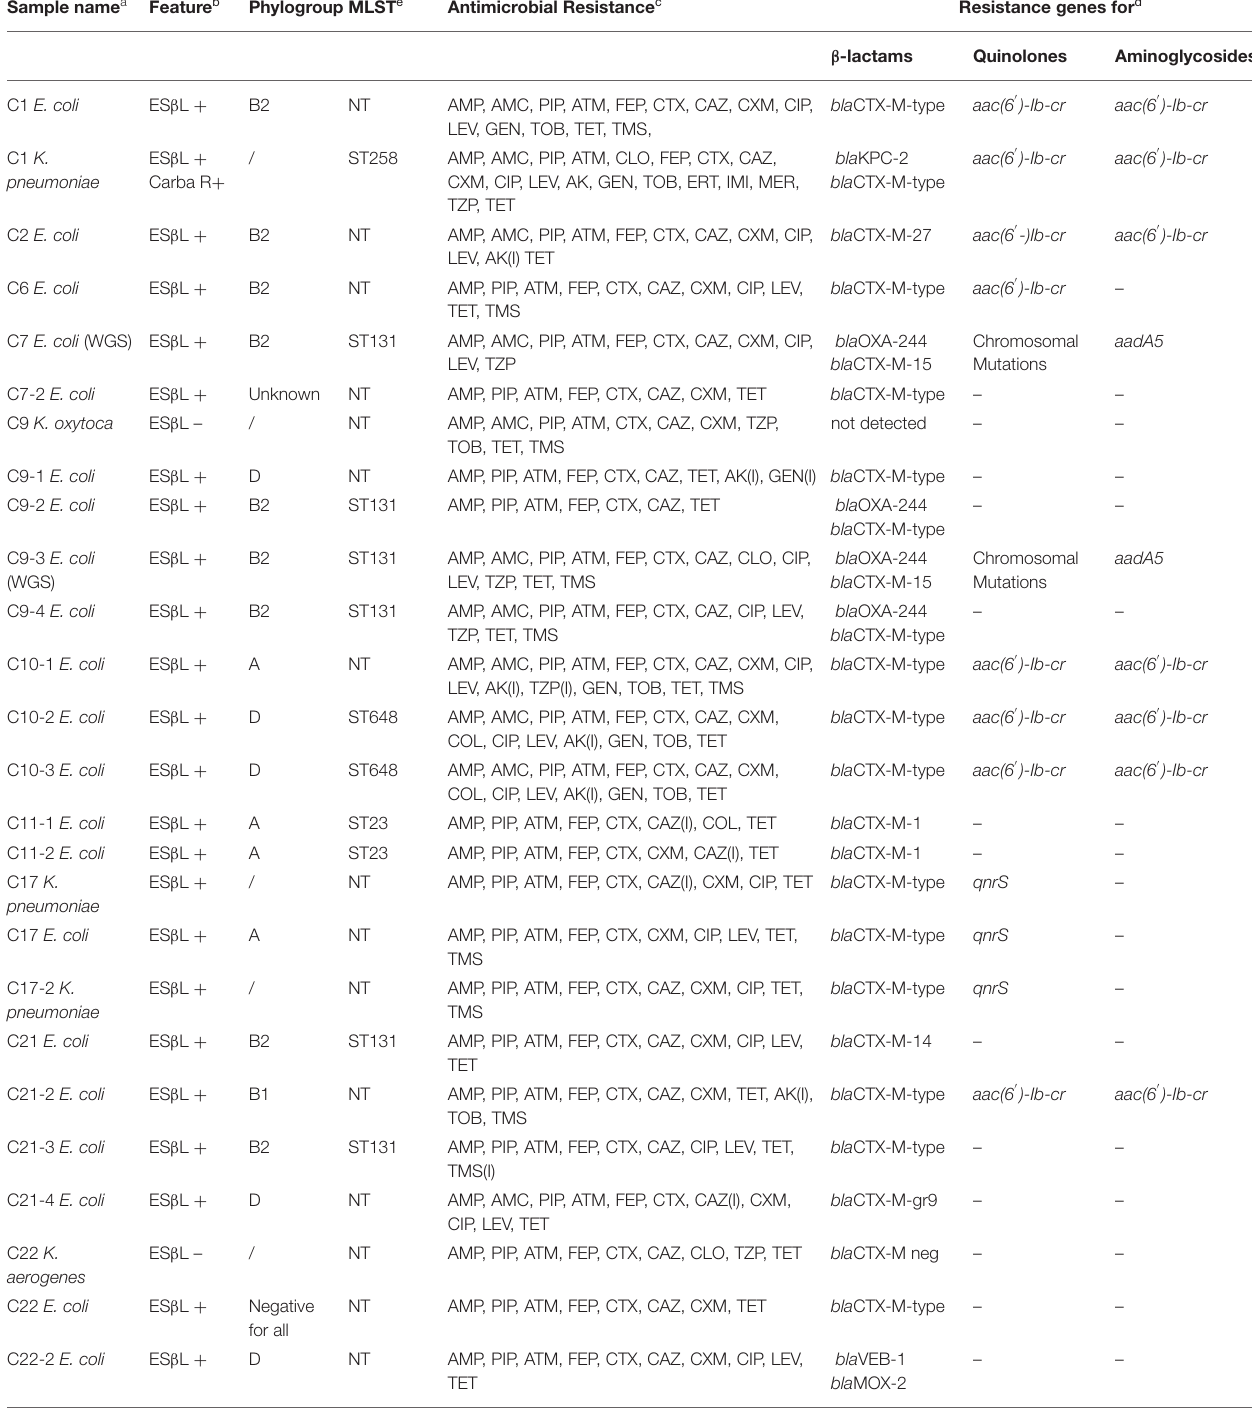
TABLE 1 | Phenotypic/molecular characteristics of ES β L/carbapenemases-producing E. coli and Klebsiella spp. isolates recovered from the 18 sampling